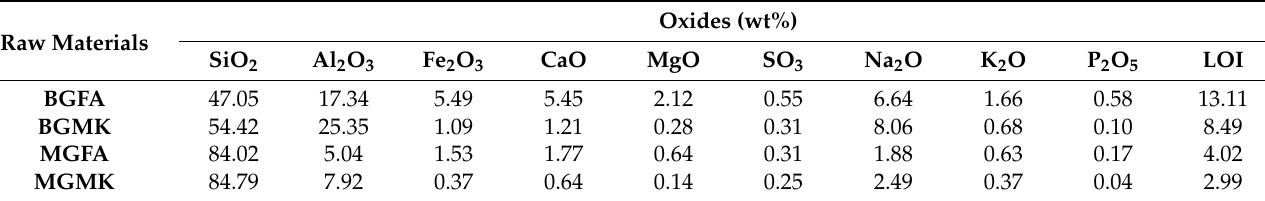
Table 3. Chemical composition of geopolymer-based